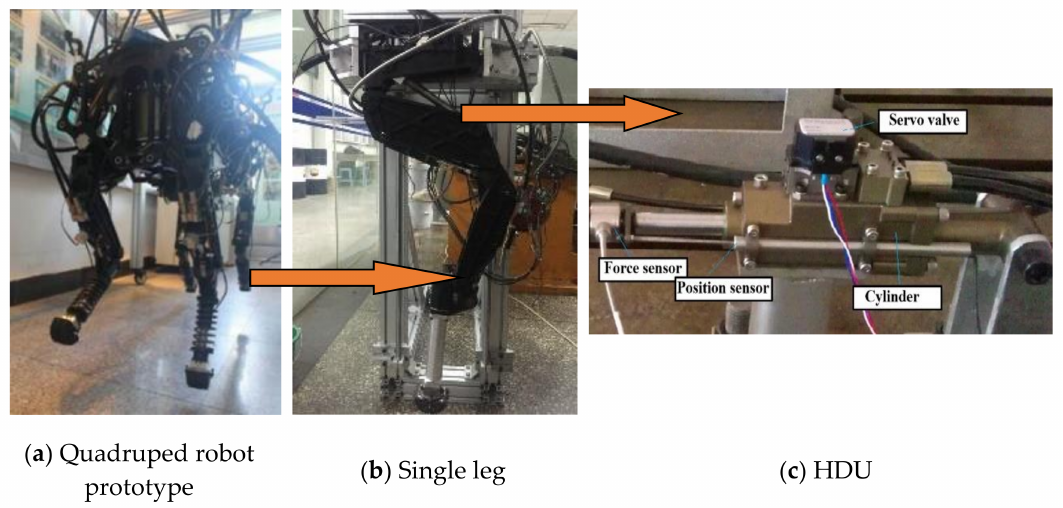
Figure 1. Photos of the quadruped robot prototype, the single leg, and the HDU.